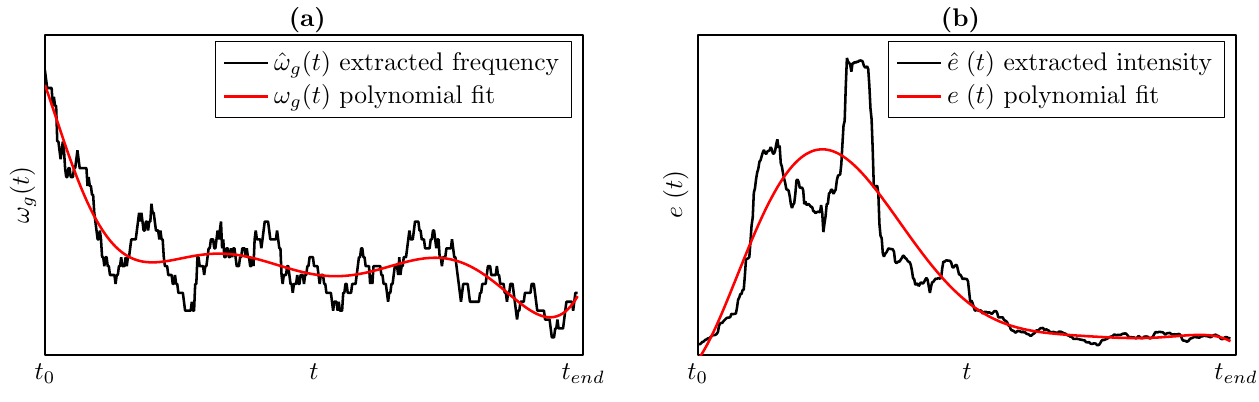
Figure 2. Extracted time-dependent properties of the recorded Northridge accelerogram, shown in Figure 1: ( a ) intensity e ( t ) extracted by the moving time window from the Northridge event; ( b ) frequency content ω g ( t ) from counted zero-crossing extracted by the moving time window of the Northridge event. The polynomial fits of the extracted parameters are highlighted in